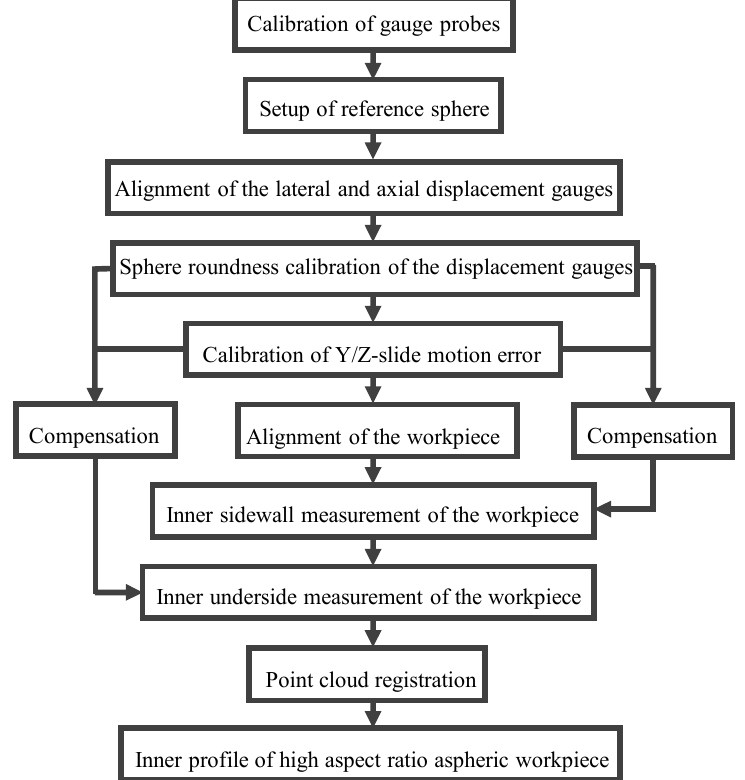
Figure 11. Schematic of the measurement procedure for inner profile surface of the high aspect ratio aspheric workpiece.